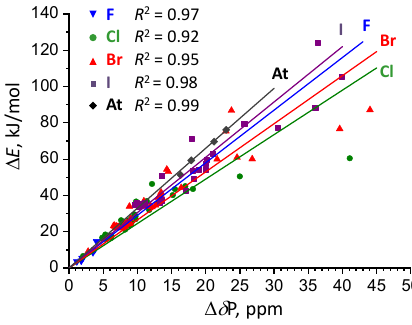
Figure 8. Correlation between calculated complexation energy ∆ E and change of the 31 P NMR chemical shift upon complexation, ∆ δ P, for R–X ··· O = PMe 3 halogen-bonded complexes studied in this work (X = F, Cl, Br, I, At). The solid lines correspond to Equation (7).